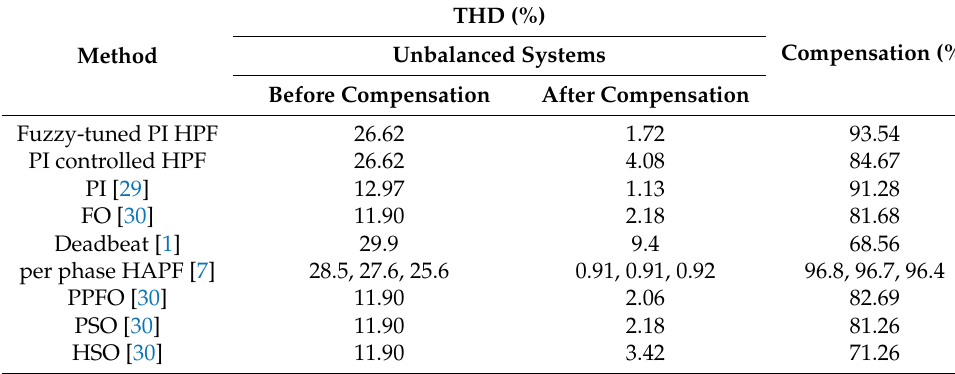
Table 4. Designed HPF performance compared to other authors’